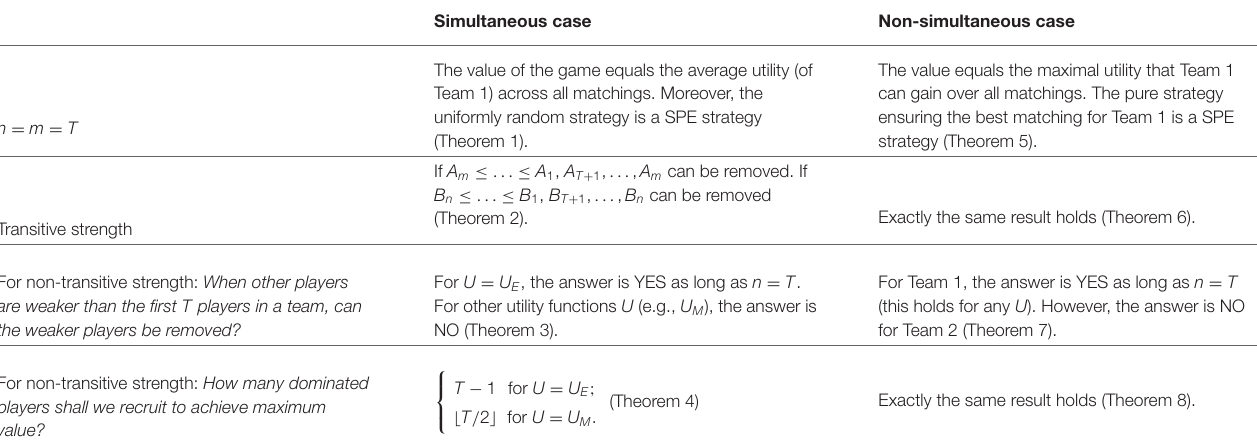
TABLE 1 | Summarize of the results for simultaneous case and non-simultaneous case.